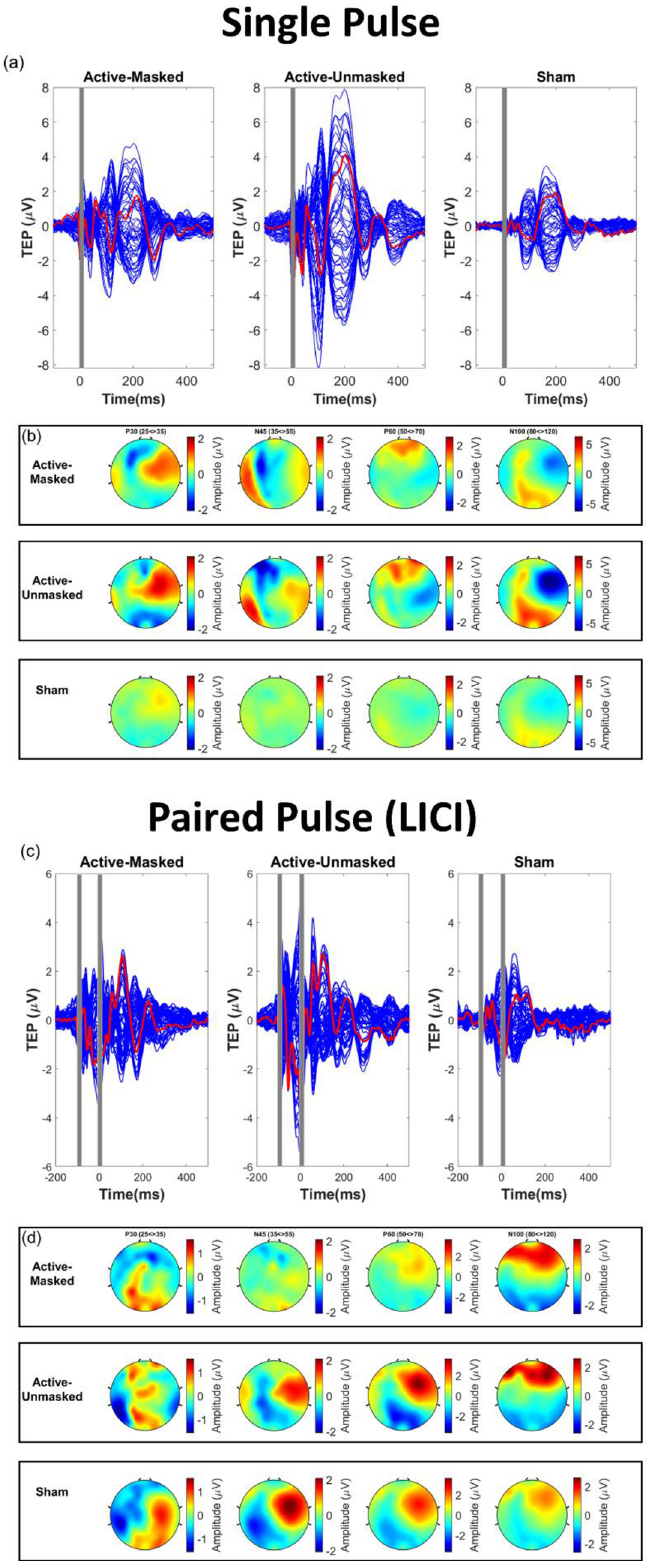
Figure 2. ( a ) Butterfly plot showing the TMS-evoked potential waveforms for each of the three single-pulse stimulation conditions. The red line is the F3 electrode located approximately over the left DLPFC. ( b ) Topoplots of the three different single-pulse stimulation conditions. ( c ) Butterfly plot showing the TMS-evoked potential waveforms for each of the three paired-pulse stimulation conditions. The red line is the F3 electrode located approximately over the left DLPFC. ( d ) Topoplots of the three different paired-pulse stimulation conditions. All plots represent the average across all